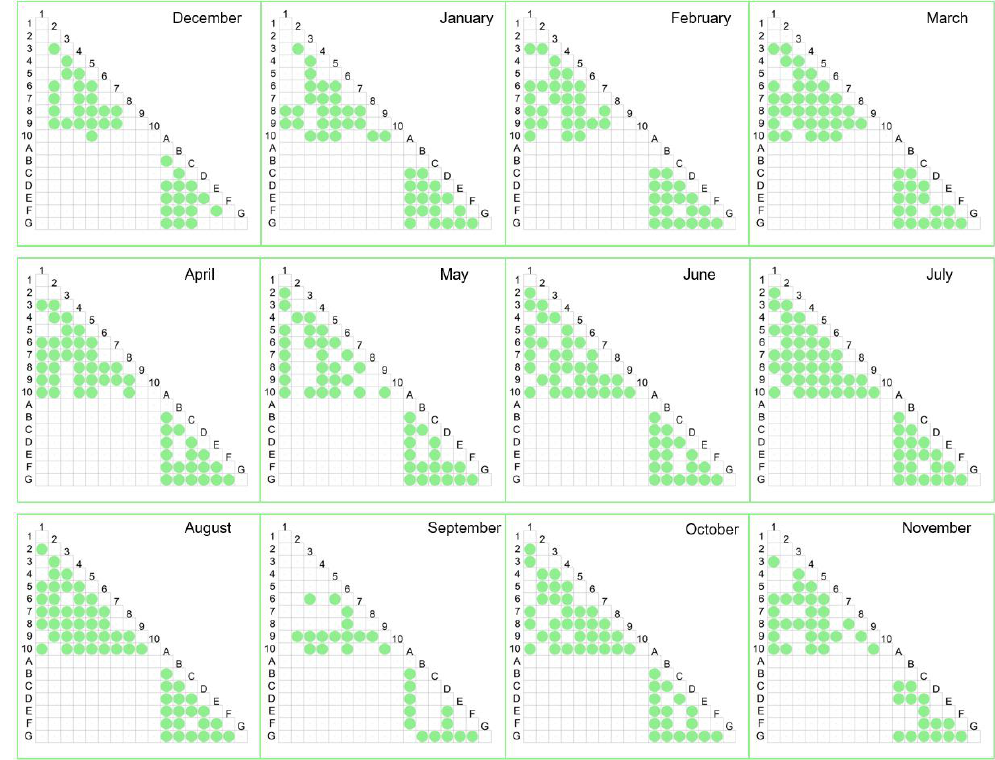
Figure 9. Difference of land surface temperatures of local climate zone types within a rural context (Circle denotes significant difference at p < 0.05 level, blank demotes no significant difference).